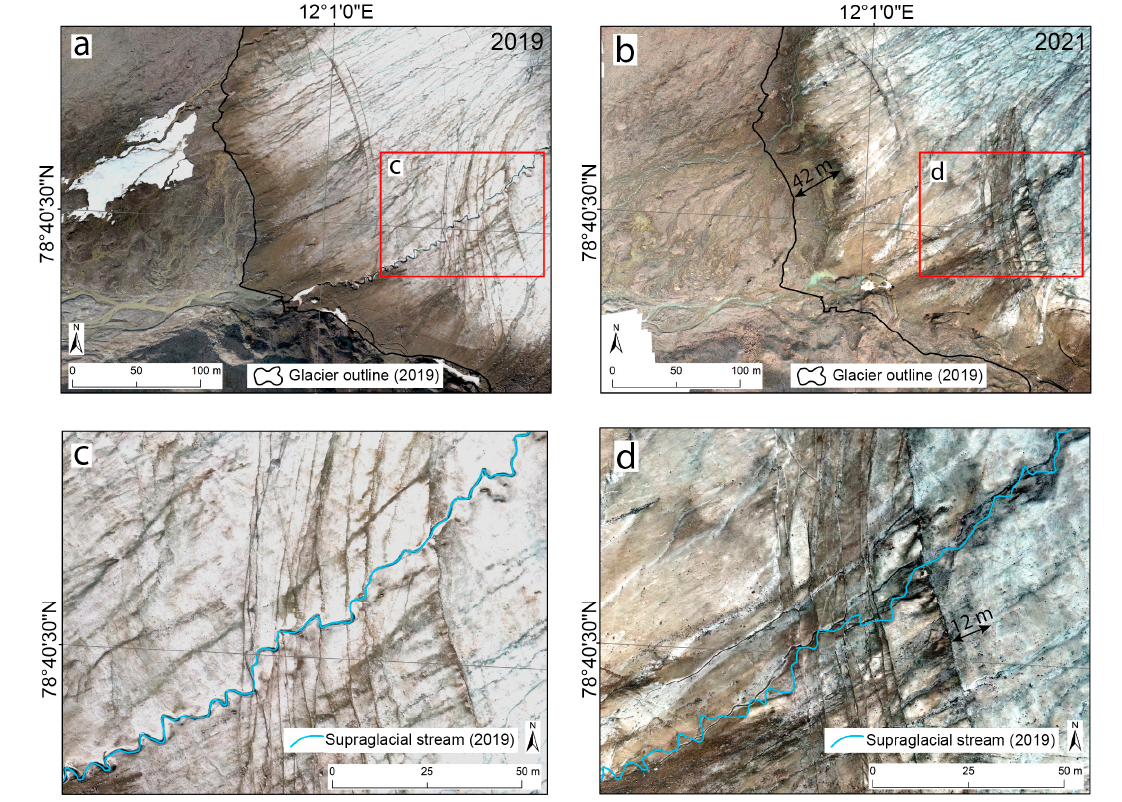
Figure 6. ( a ) Glacier terminus position in 2019; ( b ) The recession of Waldemarbreen between 2019 and 2021; ( c , d ) changes in surface drainage pattern in 2019 and